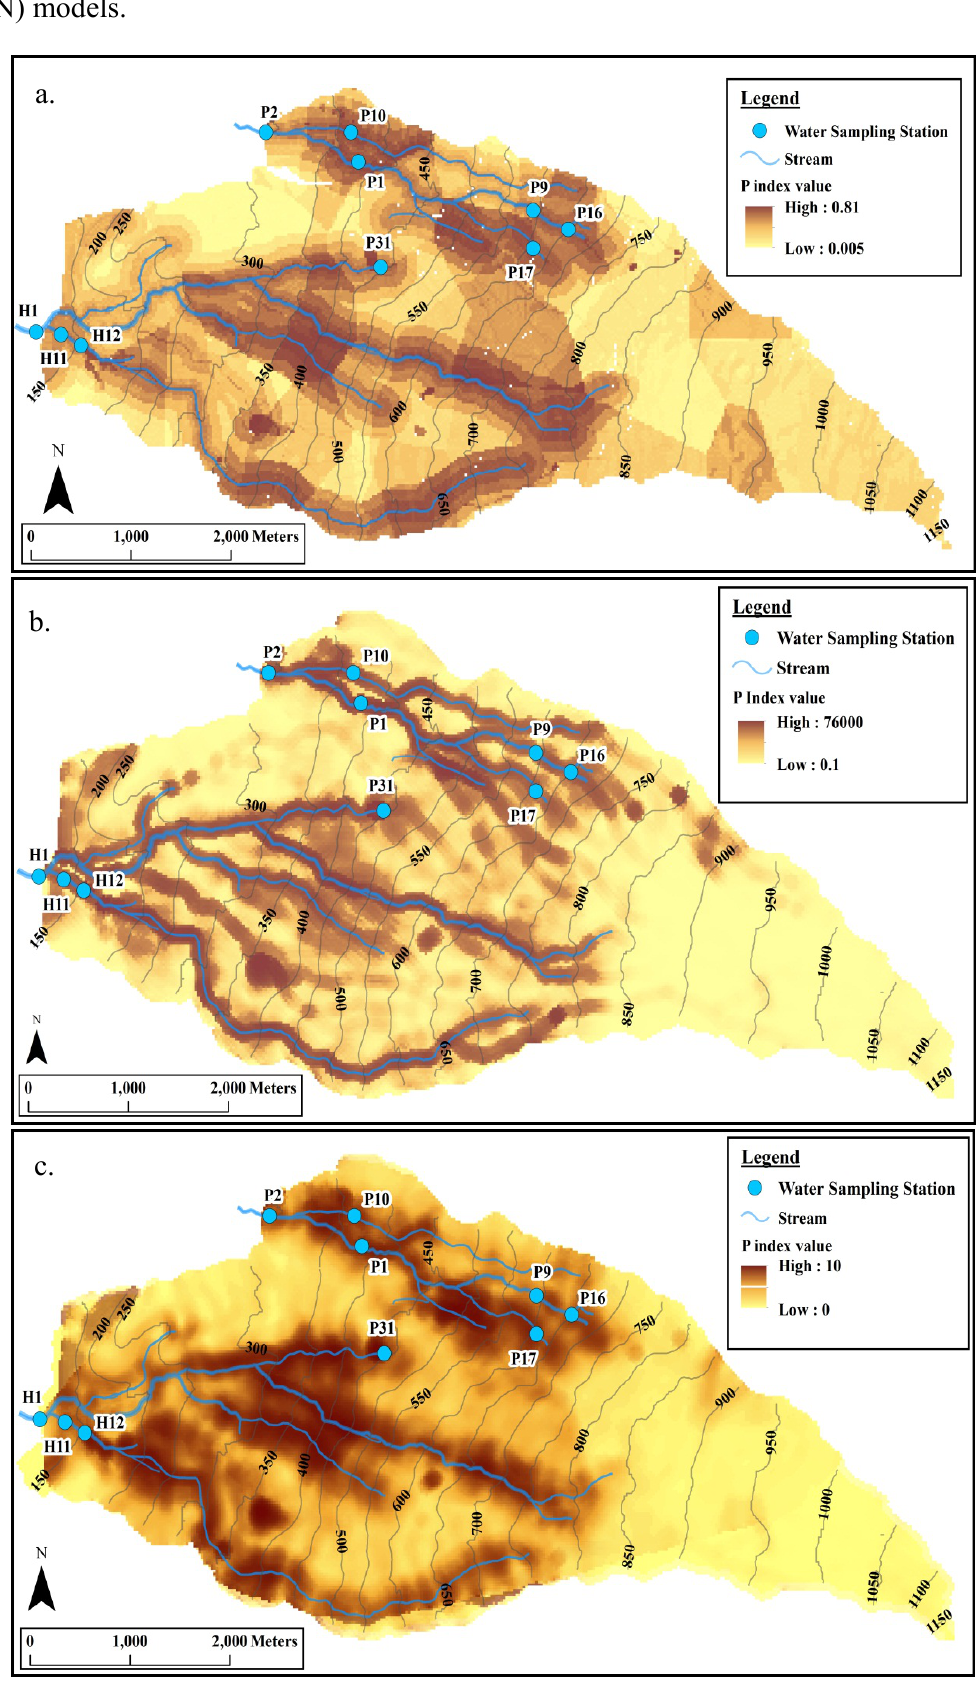
Figure 4. P-index results from the ( a ) Arkansas; ( b ) RUSLE; and ( c ) runoff curve number (RCN) models.